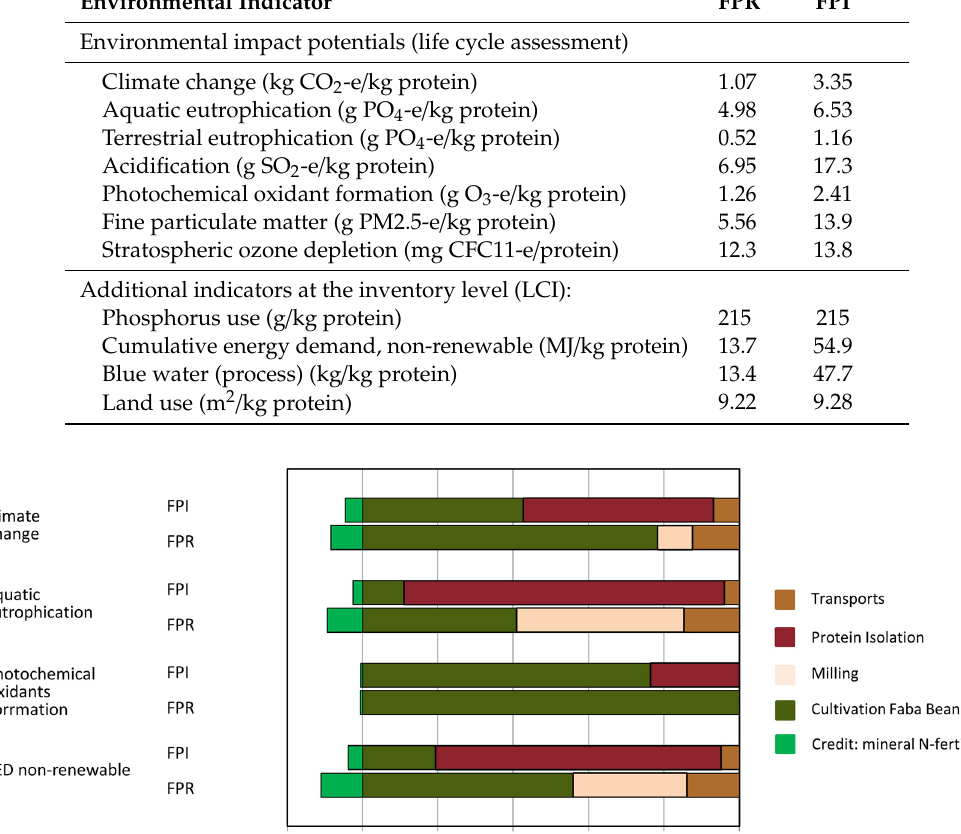
Figure 11. Contributions of main life cycle steps to environmental impact profiles of FPR and FPI; CED = Cumulative primary energy demand.